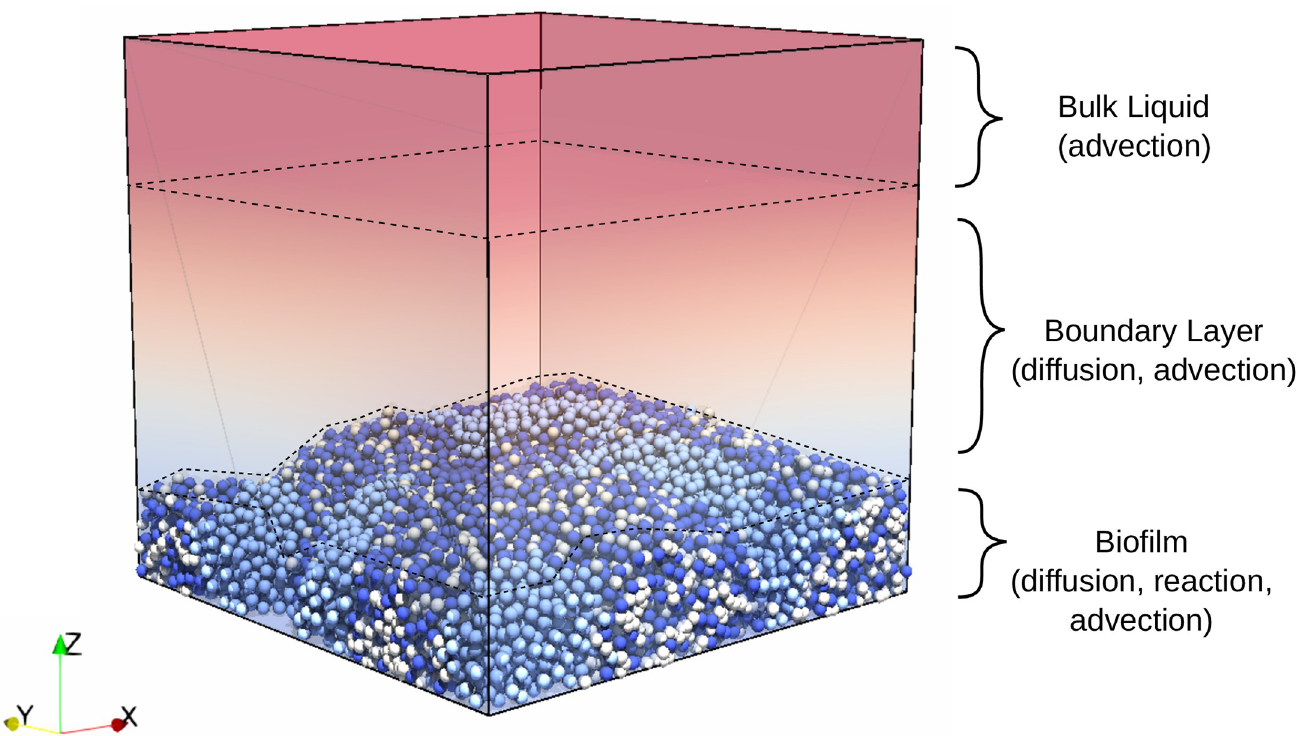
Fig 1. The computational domain with different regions. The top part is the well mixed bulk liquid region, the middle part is the diffusion boundary layer region, and the bottom part represents the biofilm region.